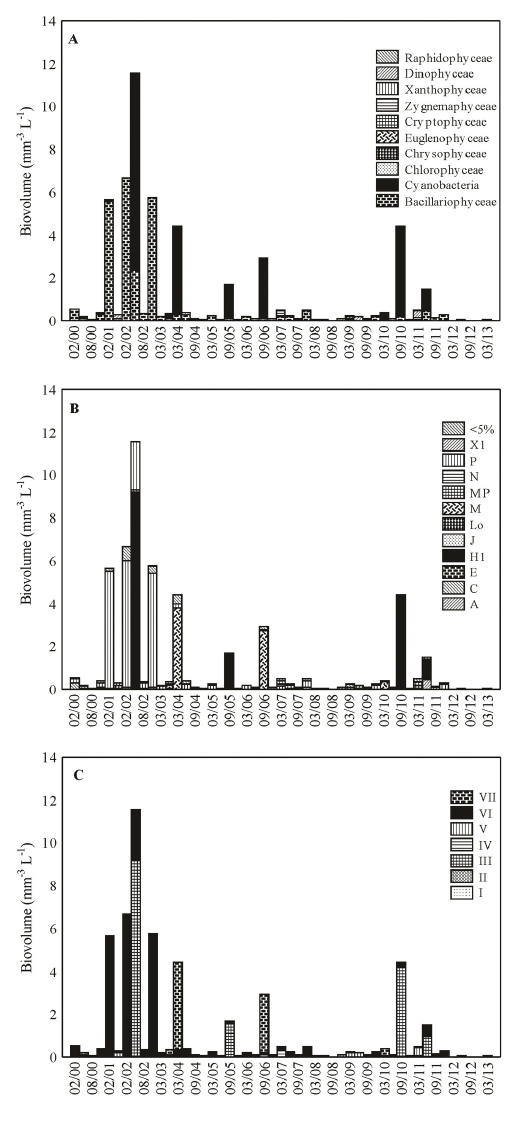
Figure 4. Interannual variation of phytoplankton by taxonomic groups (A), FGs (B) and MBFGs (C) in